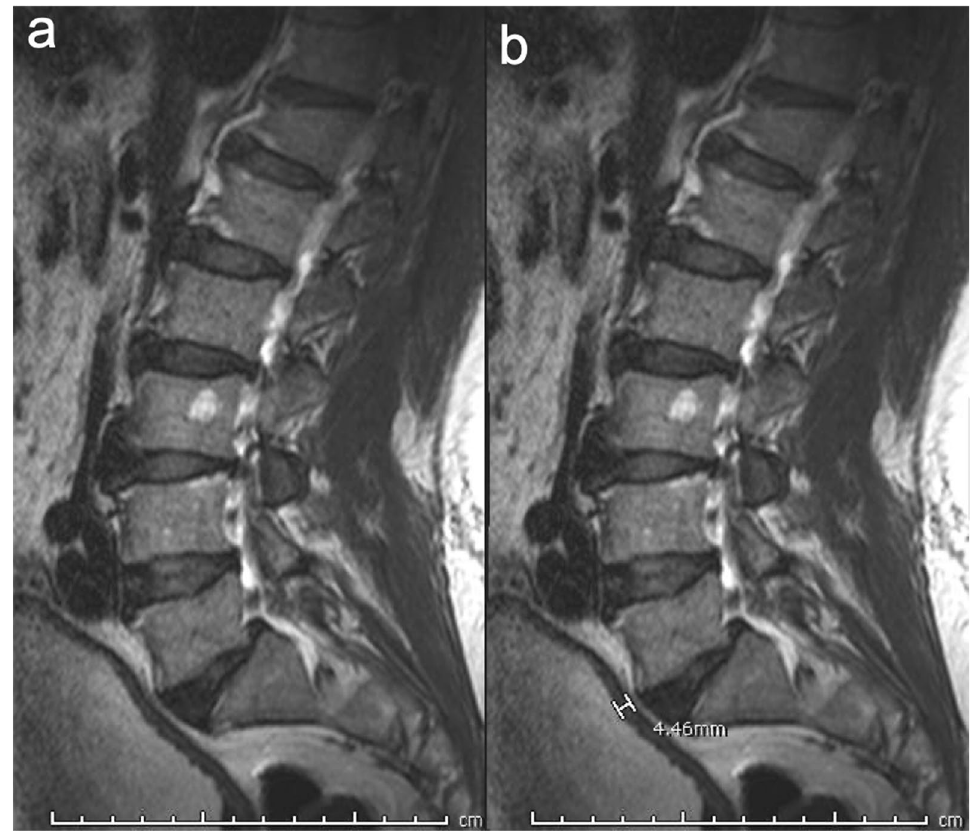
Figure 3. A 79-year-old male patient with thickened urinary bladder wall. ( a ) Sagittal T2 weighted image demonstrating thickening in the posterior wall of the urinary bladder which is well distended and partially visualized. ( b ) Sagittal T2 weighted image at this level with measurement annotation from the outer to the inner borders of the urinary bladder wall showing that it measured more than 4 mm.